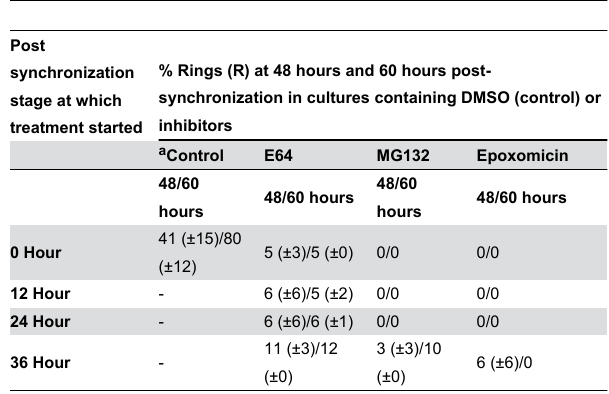
Post synchronization stage at which treatment started